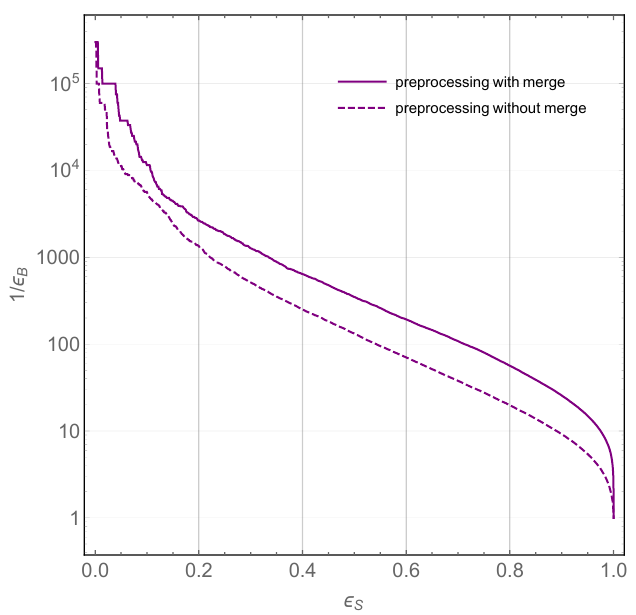
Figure 11 . ROC curves showing the performance of our top tagger on the CMS sample with and without the merge